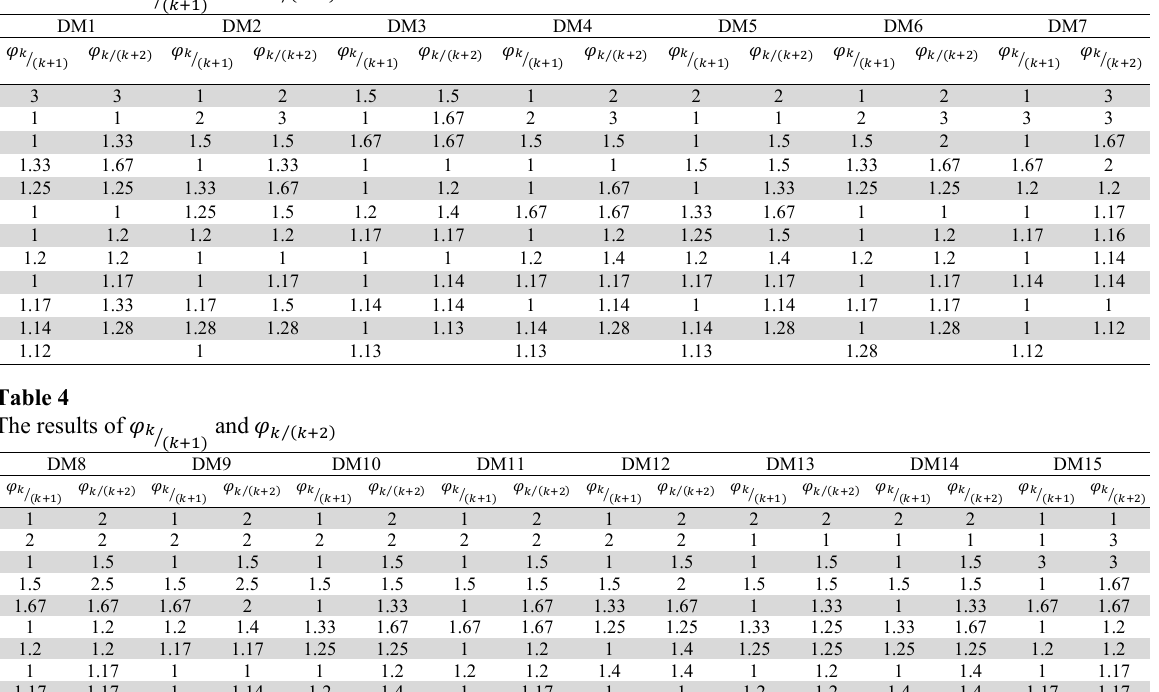
The results of 𝜑 (cid:3038)